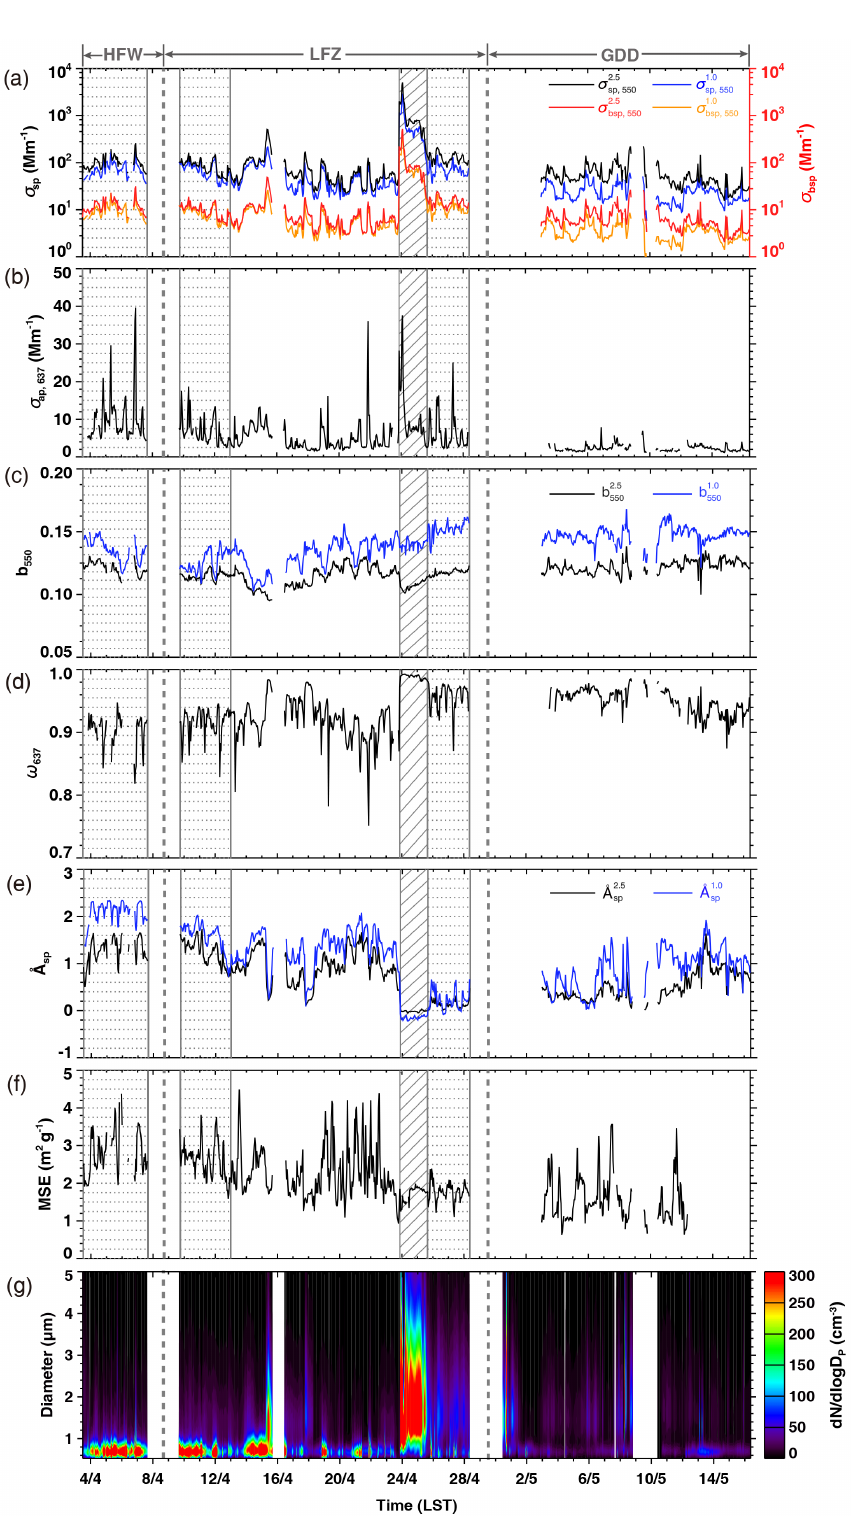
Figure 4. Temporal variations in hourly averaged (a) aerosol scattering and backscattering coefficient at 550nm; (b) absorption coefficient at 637nm; (c) the backscattering fraction at 550nm; (d) single-scattering albedo at 637nm; (e) scattering Ångström exponent (calculated from 450 to 700nm); (f) mass scattering efficiency (MSE) of PM 2 . 5 at 550nm; and (g) aerosol size distribution (d N /dlog D p , 0.5µm< D p <5µm) during the entire period from 3 April to 16 May 2014. The shaded box represents a strong dust storm that occurred in Zhangye, and the dotted boxes represent three floating dust episodes that occurred in Wuwei and